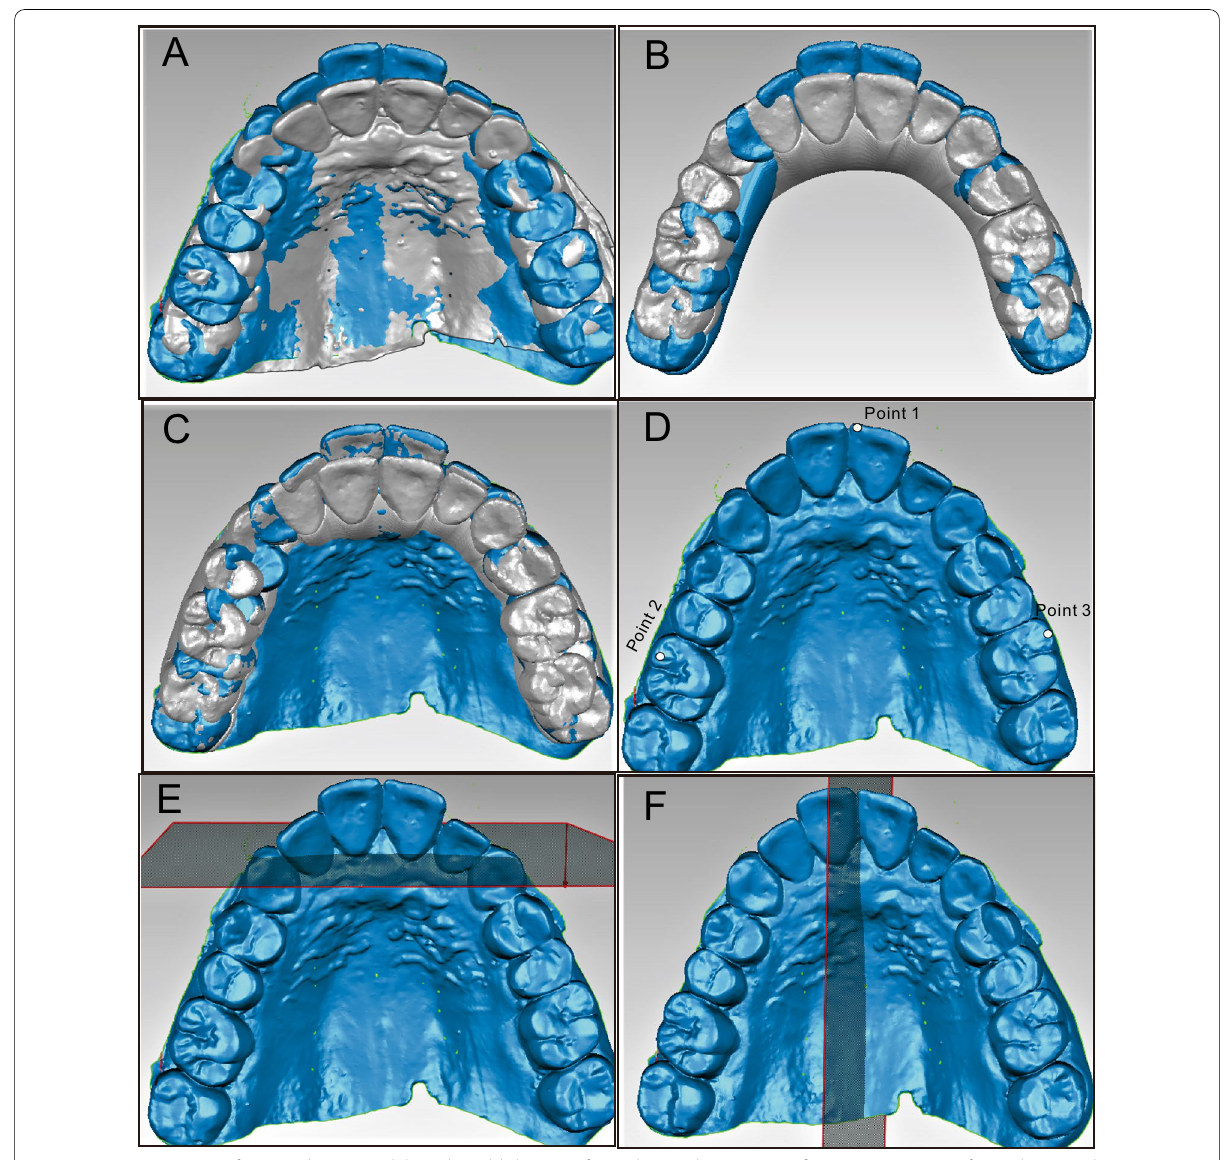
Fig. 1 Superimposition of pre- and post-models and establishment of coordinate planes. A Best-fit superimposition of actual pre- and post-treatment models based on palatal regions. B Virtual pre- and post-treatment models output from ClinCheck. C Registration of actual pre-treatment and virtual models. D Establishment of the transverse plane. E Establishment of the coronal plane; F Establishment of the midsagittal